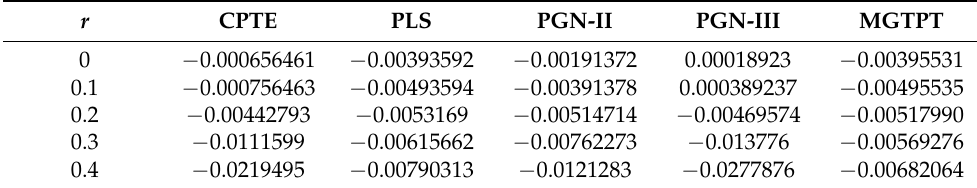
Table 4. The radial stress variation σ rr under photothermal